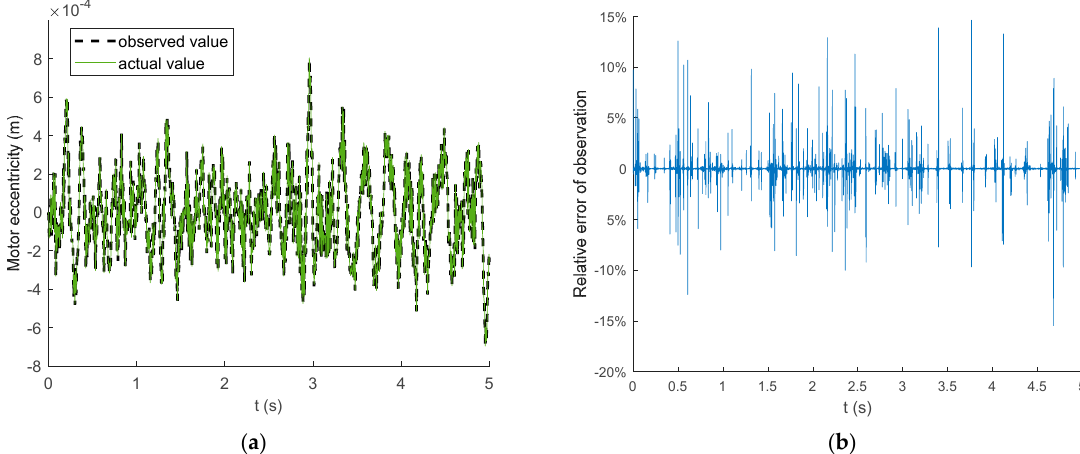
Figure 14. Observed results of vertical velocity of rotor, rim and tire. ( a ) Comparison of observed and actual values. ( b ) Relative error between observed and actual values.